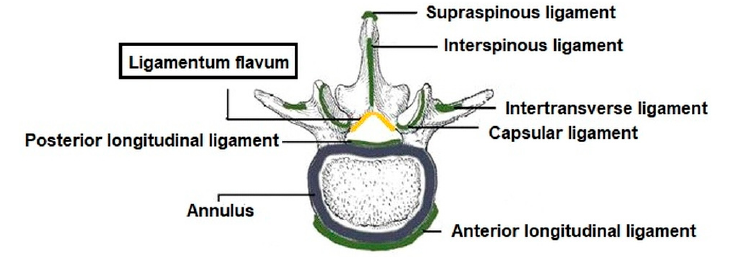
Figure 1. Ligament system stabilizing the spine.